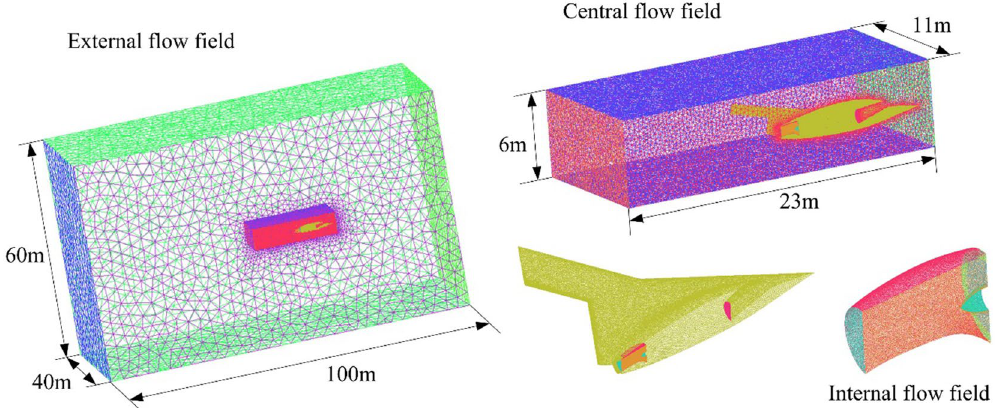
Figure 7. Aircraft exhaust system flow field construction and grid division, drawn using Microsoft Visio 2007 and ANSYS ICEM 16.0.